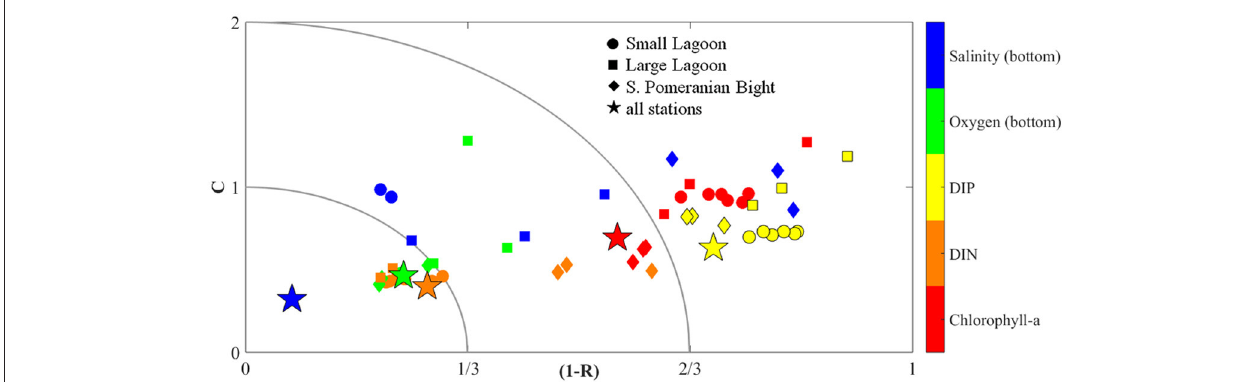
FIGURE 8 | Using the coefficient of correlation (R) and a cost-function (C), grouped into three classes (following Edman and Omstedt, 2013) the performance of the model simulation (ERGOM-MOM) with respect to chlorophyll-a (red), DIN (orange), DIP (yellow), bottom oxygen (green) and salinity (blue) is shown for Small Lagoon (circles), Large Lagoon (squares), Southern Pomeranian Bight (diamonds) and combined for all stations